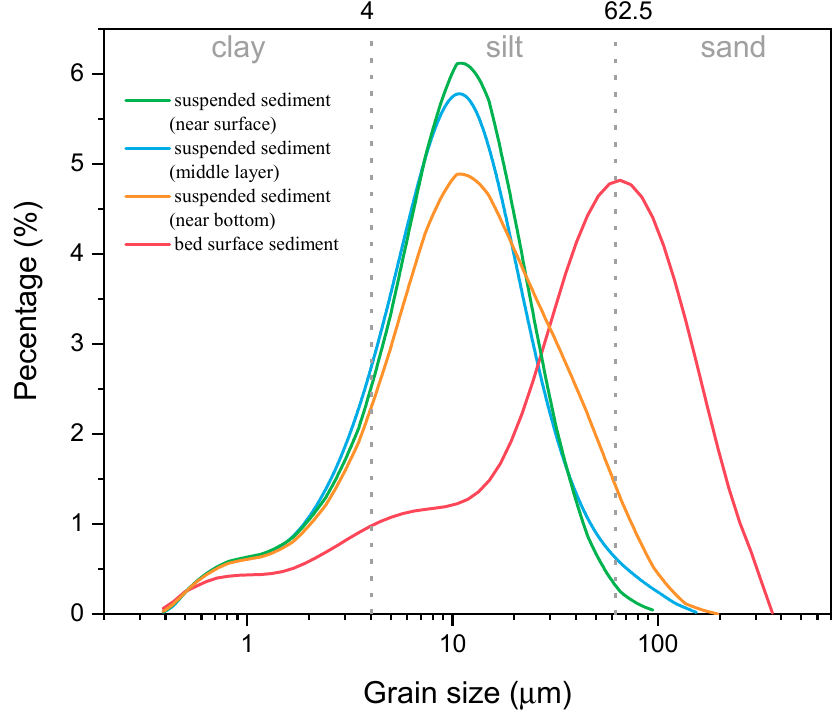
Figure 2. Grain-size distributions of the samples of suspended sediment (curves in green, blue, and orange) and bed surface sediment (red curve). The dotted lines mark the grain-size range of silt (4~62.5 µ μ m).